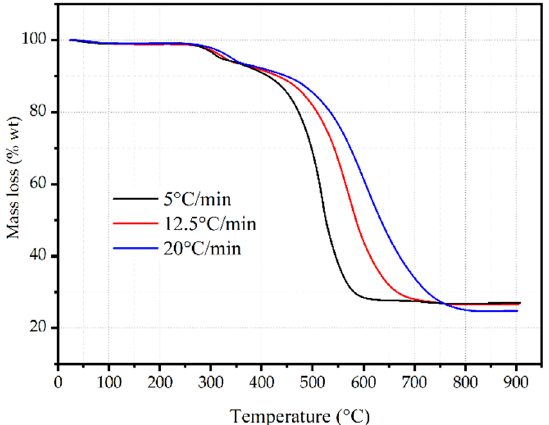
Figure 7. TG curves for 90HC10PS at 5, 12.5, and 20 °C/min heating rates under an air atmosphere.